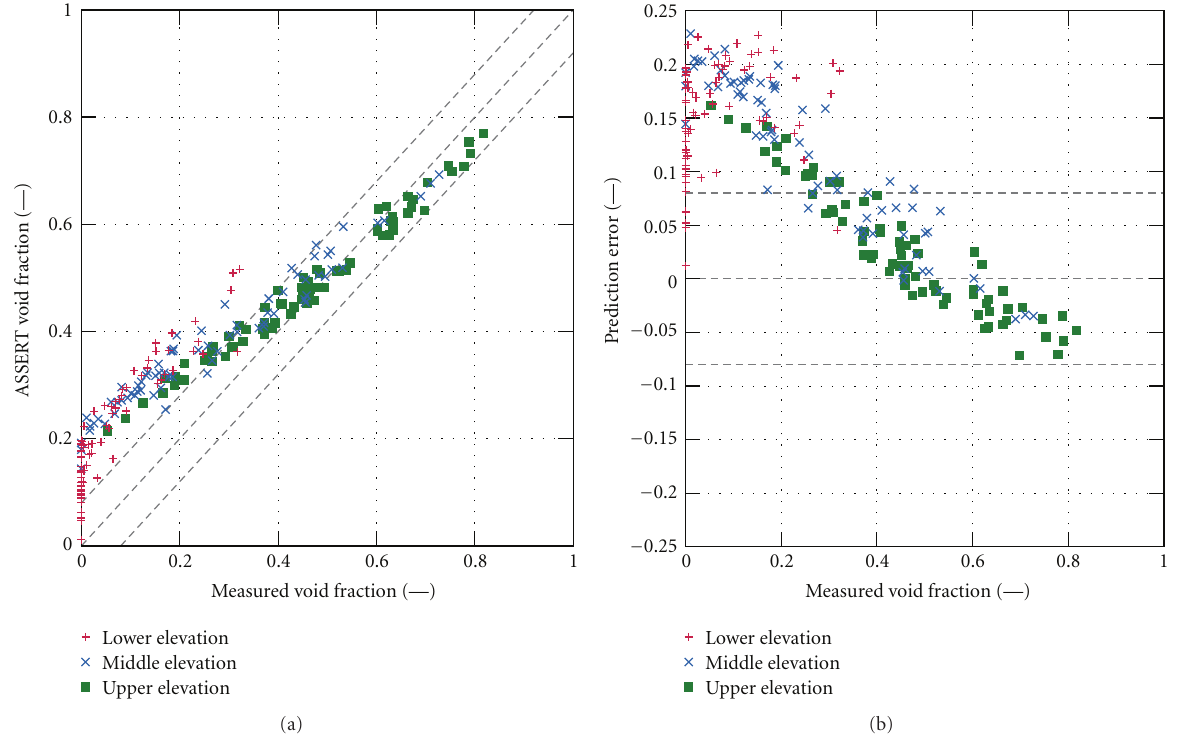
Figure 10: Steady state void fraction results for bundle test series B7. Error bands displayed correspond to 2 σ exp = 0 . 08.